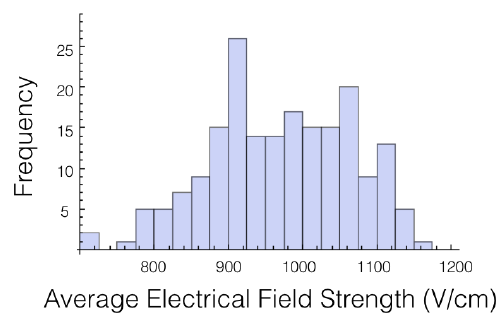
Figure 2. Historgam of the average electrical field experienced by the tumor at 1725 V for case 1. Roughly follows a normal distibution.